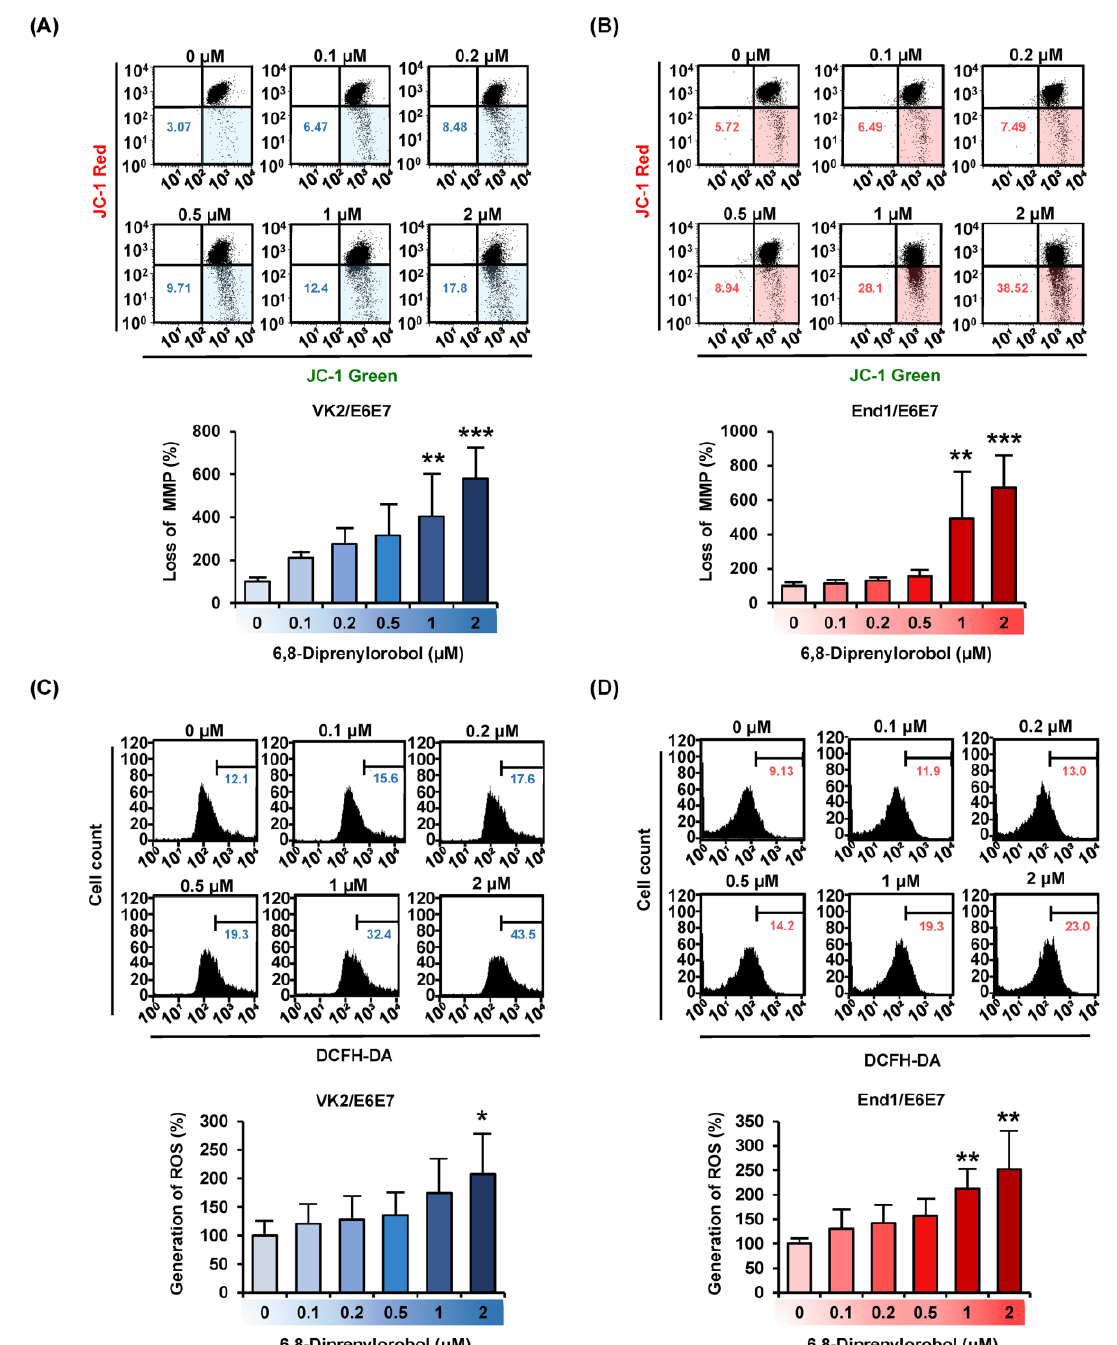
Figure 2. Effects of 6,8-diprenylorobol on mitochondrial function and ROS production in VK2/E6E7 and End1/E6E7 cells. ( A , B ) MMP in VK2/E6E7 and End1/E6E7 cells was confirmed by JC-1 dye with flow cytometry (FACS). ( C , D ) The human endometriosis cells were stained with DCFH-DA to detect the production of reactive oxygen species (ROS) via FACS. Asterisks indicate significant levels between vehicle-treated cells and 6,8-diprenylorobol-treated cells (* p < 0.05, ** p < 0.01, and *** p < 0.001). in Human Endometriosis-Like Cell Lines Calcium homeostasis disruption could lead to mitochondrial dysfunction. Therefore, to measure the interfering effect of 6,8-diprenylorobol on calcium homeostasis in human